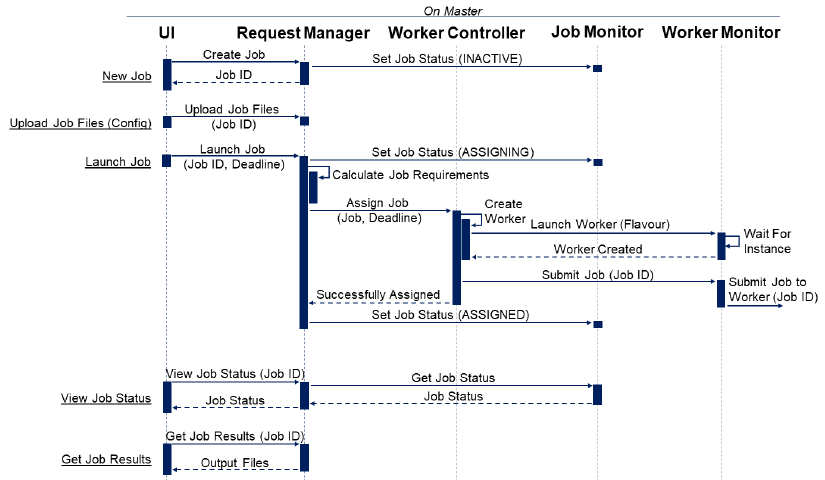
Figure 4. Master-node sequence diagram.